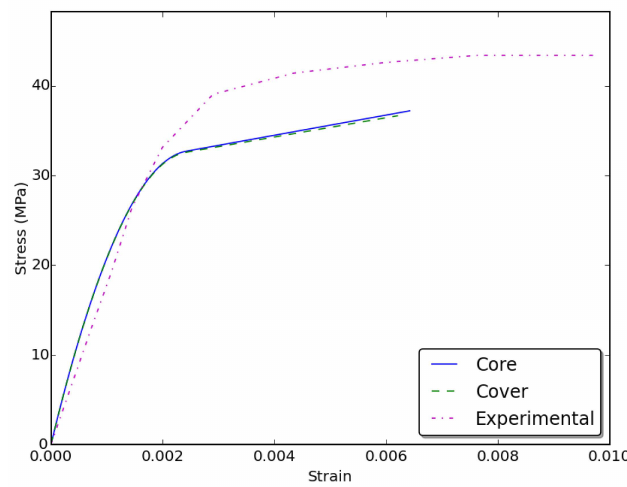
Figure 16. Stress-strain curves for Specimen C30S100N2.